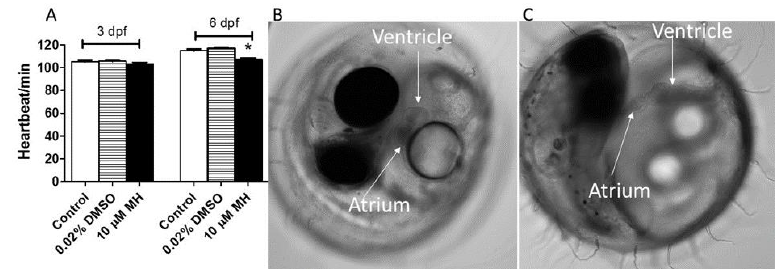
Figure 4. MH is responsible for the defect in cardiac function in vivo. Embryos were exposed to 10 μM MH or 0.02% DMSO ( which was used as solvent in the treated condition) as the control from 5 hpf to 6 dpf. Heartbeat, blood flow, and heart structure were evaluated. ( A ) Heart beat was recorded and expressed as beats per min. Bar graphs of results obtained by counting heart beats. Results